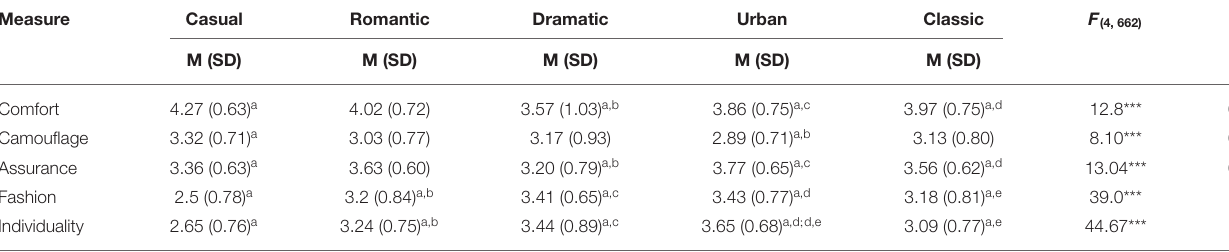
TABLE 5 | One-way ANOVA for testing clothing functions and clothing styles ( N = 792). Measure